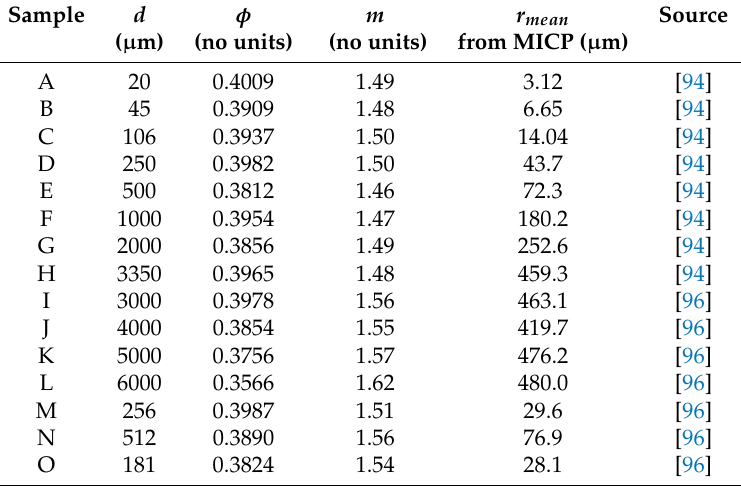
Properties for a set of glass bead packs reported in [94,96]. Symbols of d ( µ m), φ (no units), m (no units), and r mean ( µ m) stand for the grain diameter, porosity, cementation exponent, and mean pore radius of glass bead samples from mercury injection capillary pressure (MICP) measurements, respectively.